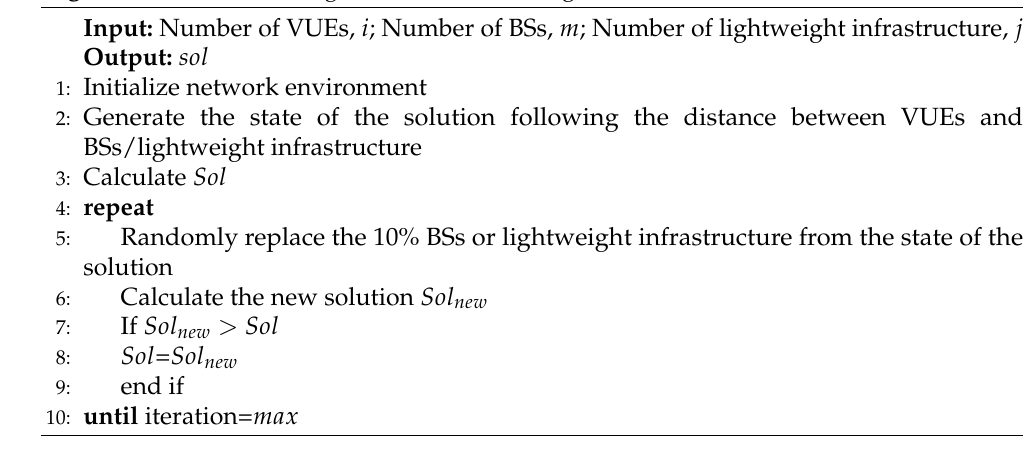
Algorithm 1 Hill-Climbing-based Handover Algorithm